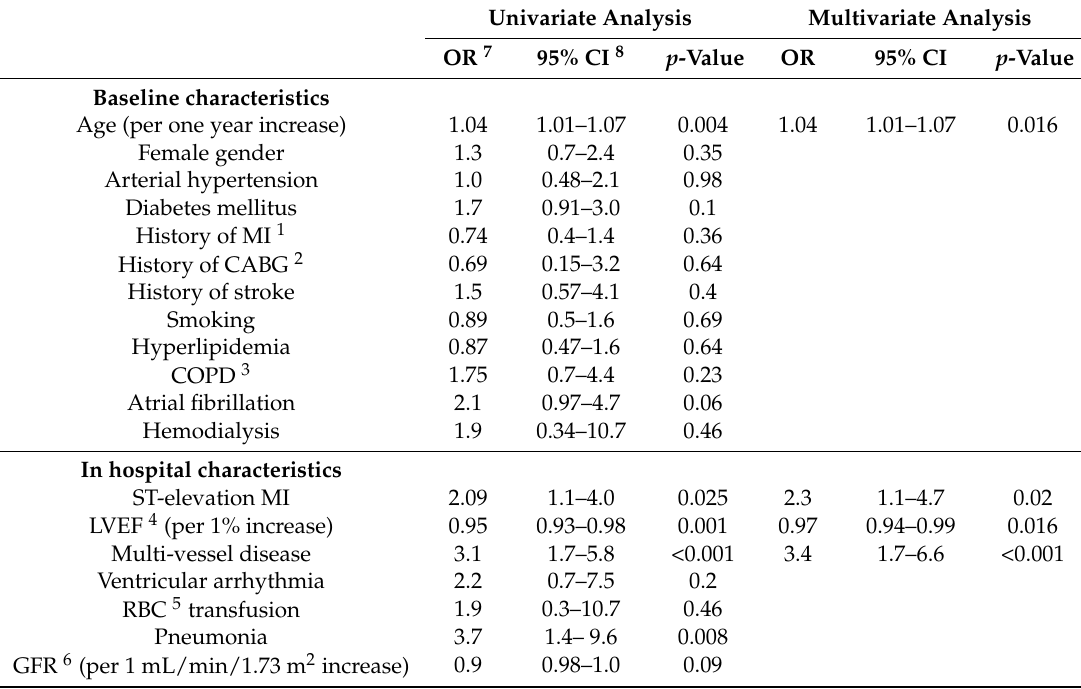
Table 4. Logistic regression model for predicting hospitalization lengths ≥ 8